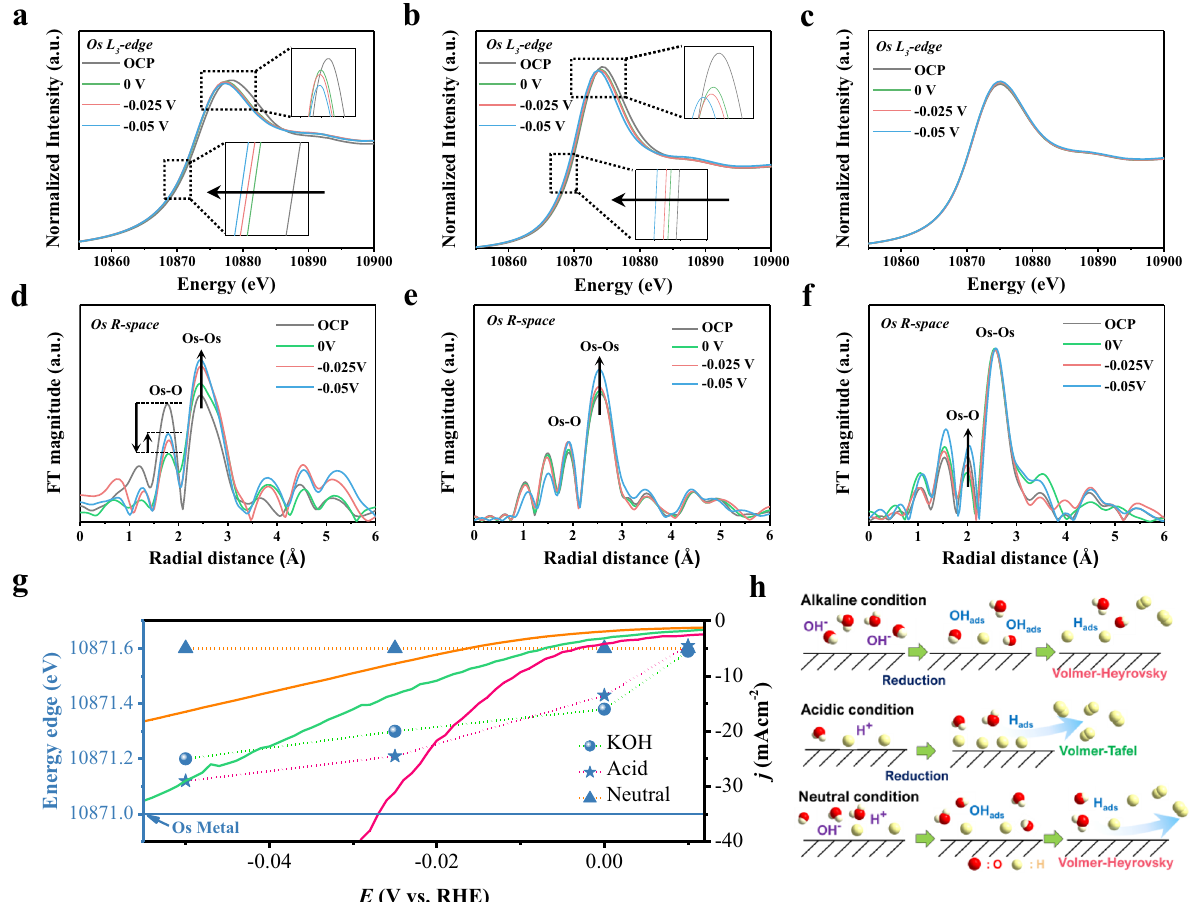
Fig. 4 Operando investigation of HER behaviors in various electrolyte environments. a Operando XANES spectra of Os-B in 1.0 M KOH, b in 0.5 M H 2 SO 4 and c in 1.0 M PBS. d Operando EXAFS spectra of Os-B in 1.0 M KOH, e in 0.5 M H 2 SO 4 and f in 1.0 M PBS. g The polarization curve and the corresponding position of the Os energy edge obtained with a fi rst-derivative method. h Schematic illustration of HER mechanism in various electrolyte